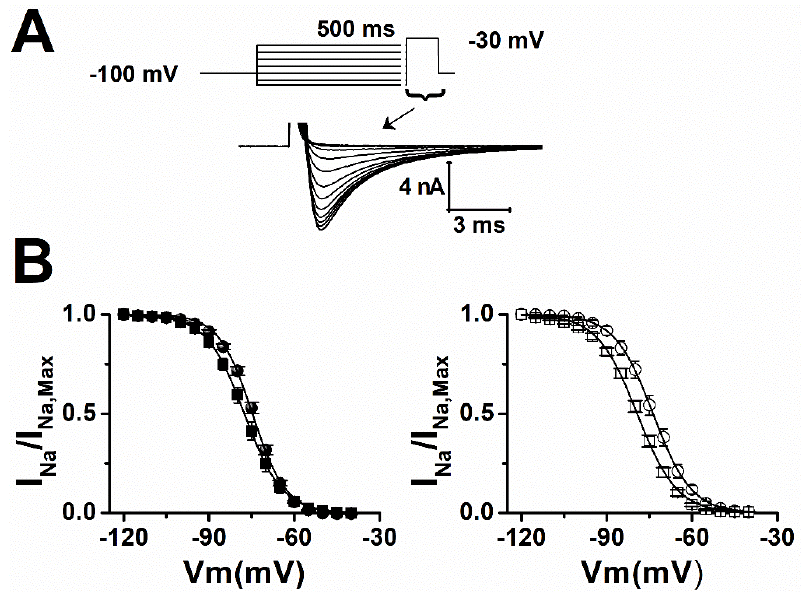
Figure 3. LTG hyperpolarized I Na steady state-inactivation. ( A ) Representative I Na inactivation recording obtained during a 15 ms test pulse to −30 mV following a series of 500 ms conditioning potentials from −120 to −40 mV in 5 mV increments (top). ( B ) Steady-state inactivation curves for sham (filled symbol) and epileptic (open symbol) animals in control conditions (circles) and 10 µmol/L of LTG (squares). Data points (±SEM) were fitted using a Boltzmann function (solid line). Number of animals: 3/group (ctrl and LTG). Number of cells: Sham (ctrl, LTG):15, 11; Epileptic (ctrl, LTG): 12, 19. Table 2. Na + channel inactivation parameters for control conditions and during exposure